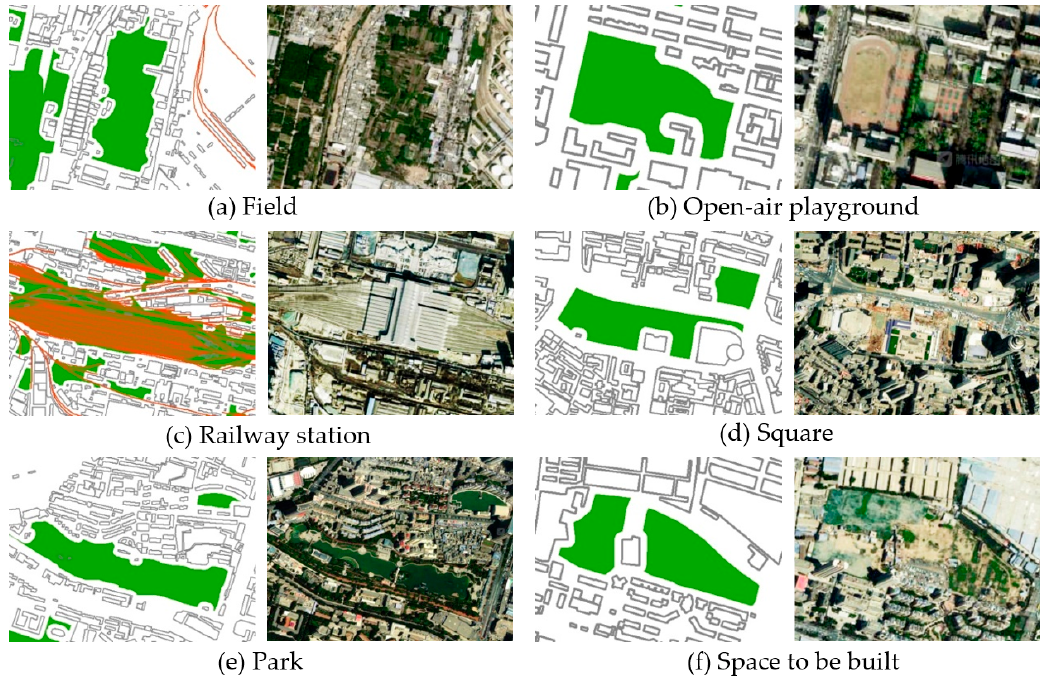
Figure 14. Examples of free spaces obtained from 1:10K buildings (left) and image map (right): ( a ) field; ( b ) open-air playground; ( c ) railway station; ( d ) square; ( e ) park; and ( f ) space to be built.